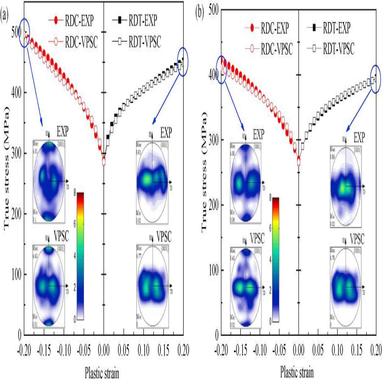
Comparison of the experimental and the predicted results at (a) 423 K and (b) 523 K, indicating that the experimental results are well reproduced using the multi-object optimization method.